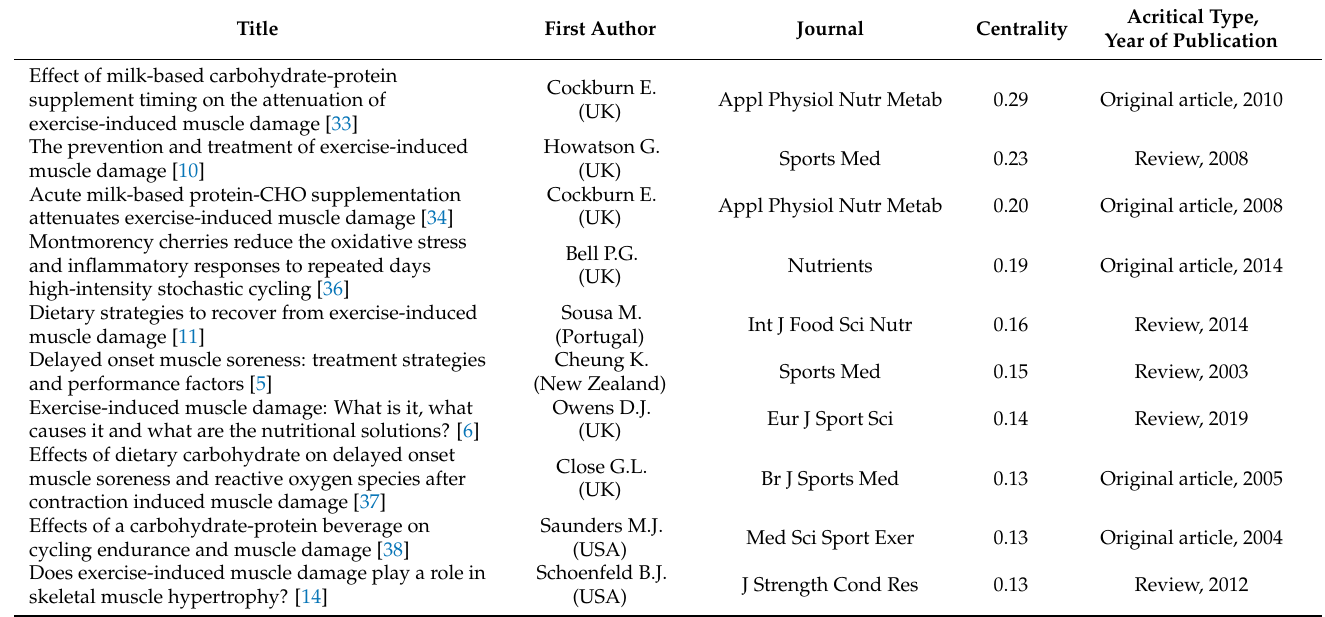
Table 3. The top ten EIMD and protein intake studies with the highest